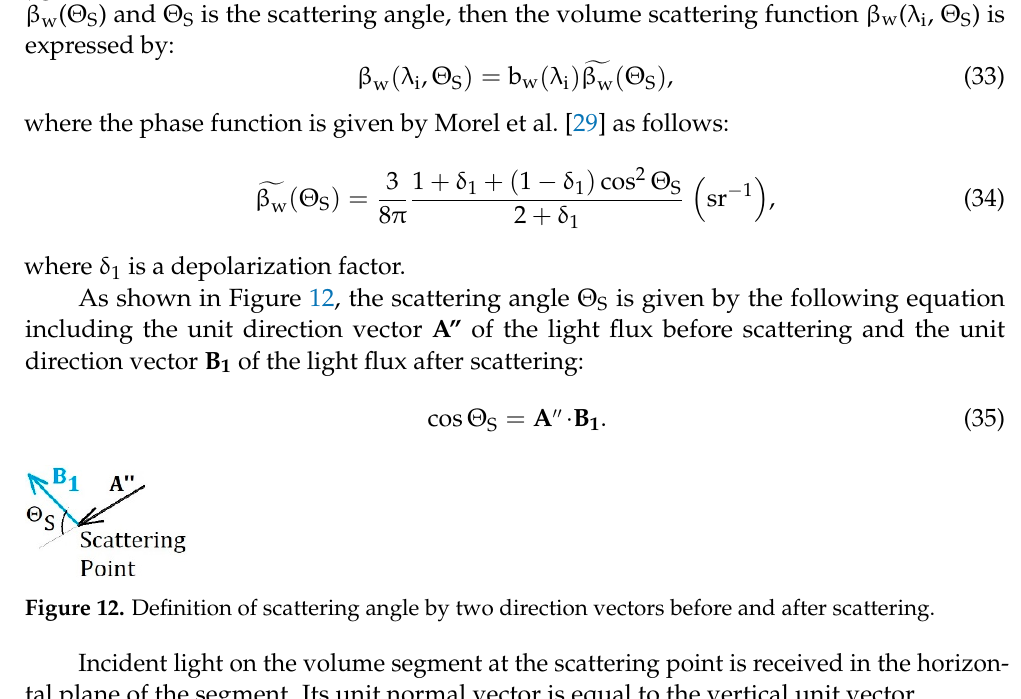
Figure 12. Definition of scattering angle by two direction vectors before and after scattering. Incident light on the volume segment at the scattering point is received in the horizontal plane of the segment. Its unit normal vector is equal to the vertical unit vector.